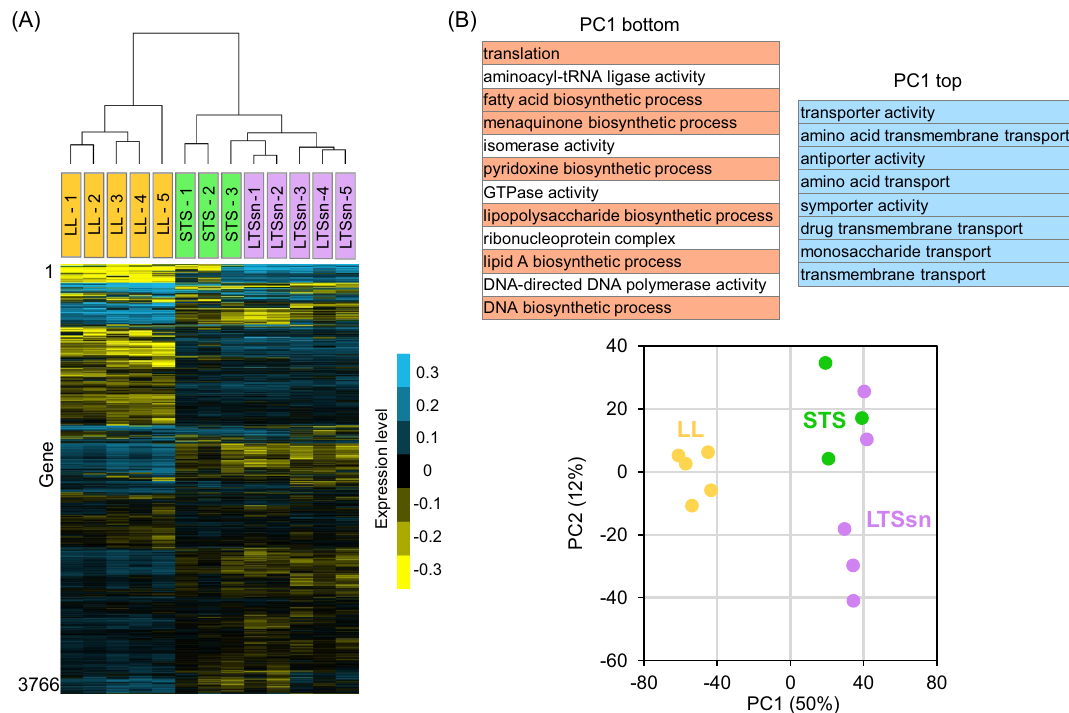
Figure 2. Comprehensive analysis of gene expression data. ( A ) Heatmap of the expression levels in 3,766 genes in the late-log phase culture (LL, n = 5), the short-term stationary phase culture (STS, n = 3), or the long-term stationary phase supernatant (LTSsn, n = 5). In each gene, the expression data were normalized to the mean value of all samples. We performed clustering both by genes and arrays using the average linkage method based on the Euclidean distance among the samples or genes. ( B ) Plots of PCA scores from the analysis using all analyzed samples. Plots indicate scores of individual samples in each condition. The percentage displayed on each axis is the rate of the contribution of PC1 or PC2. GO terms that have significant positive or negative contributions are displayed as PC1 top or bottom groups. GO terms associated with, “transport” and “biosynthetic process” are colored red and blue. All extracted gene sets are shown in Supplementary Data